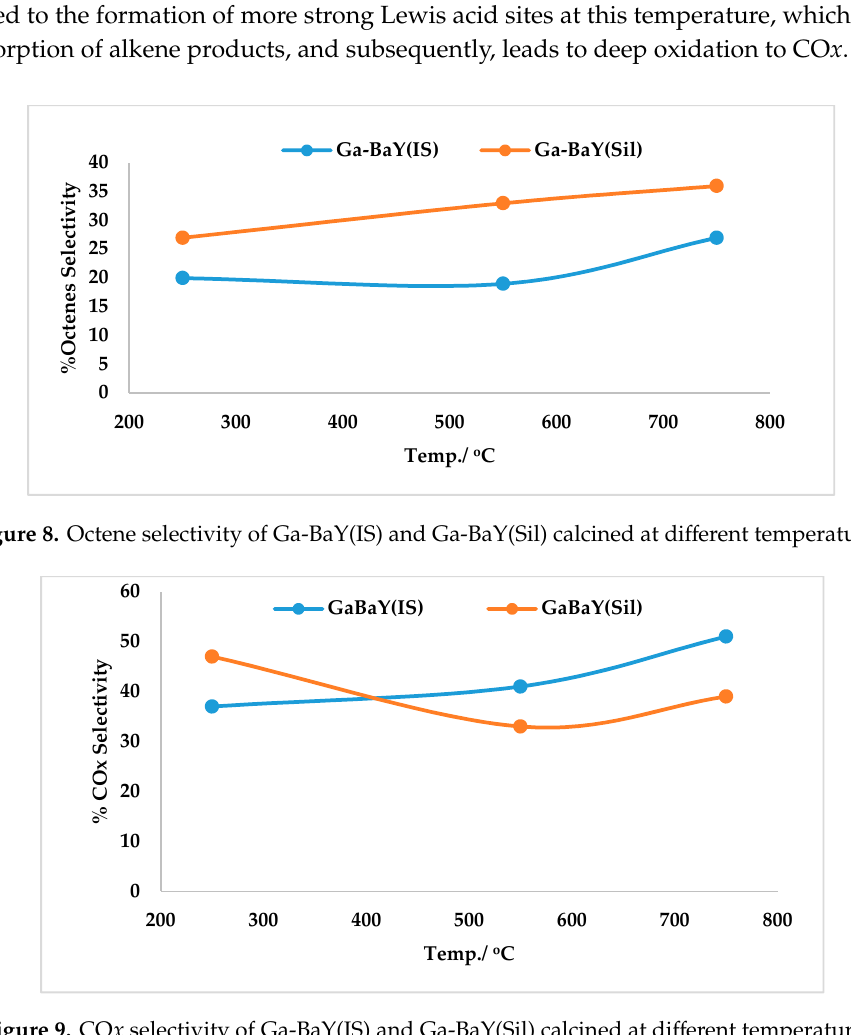
Figure 9. CO x selectivity of Ga-BaY(IS) and Ga-BaY(Sil) calcined at di ff erent